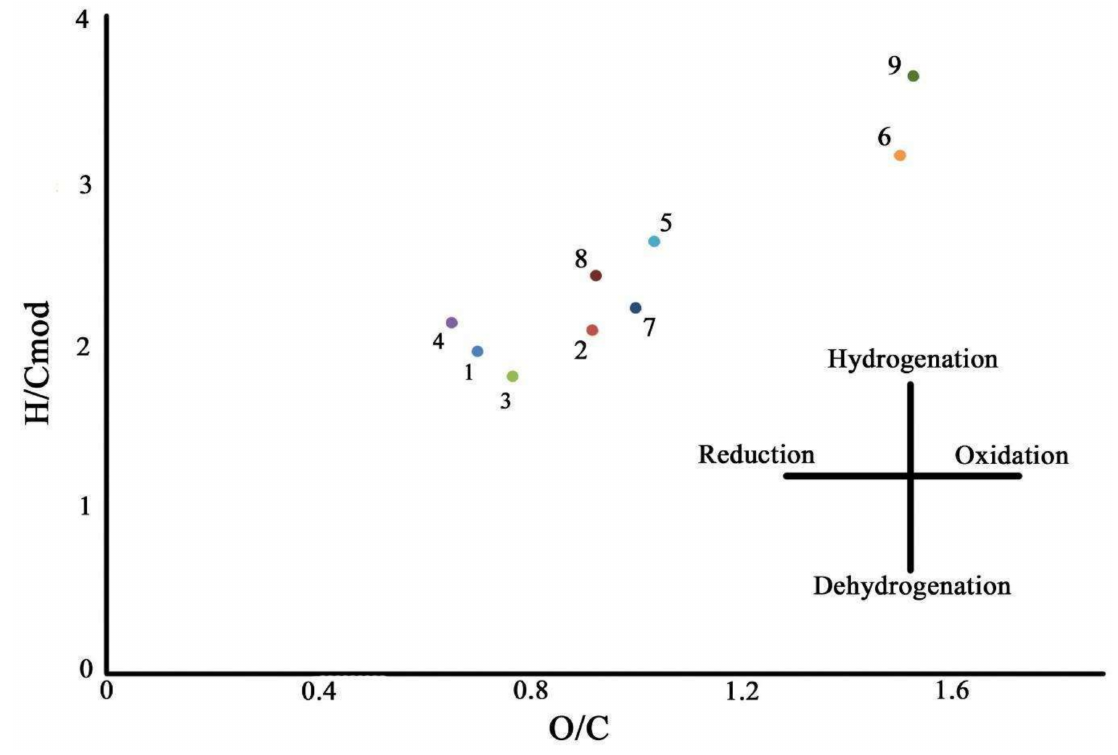
Figure 2. The van Krevelen diagram of elemental composition of HAs. Sample ID corresponds to Table